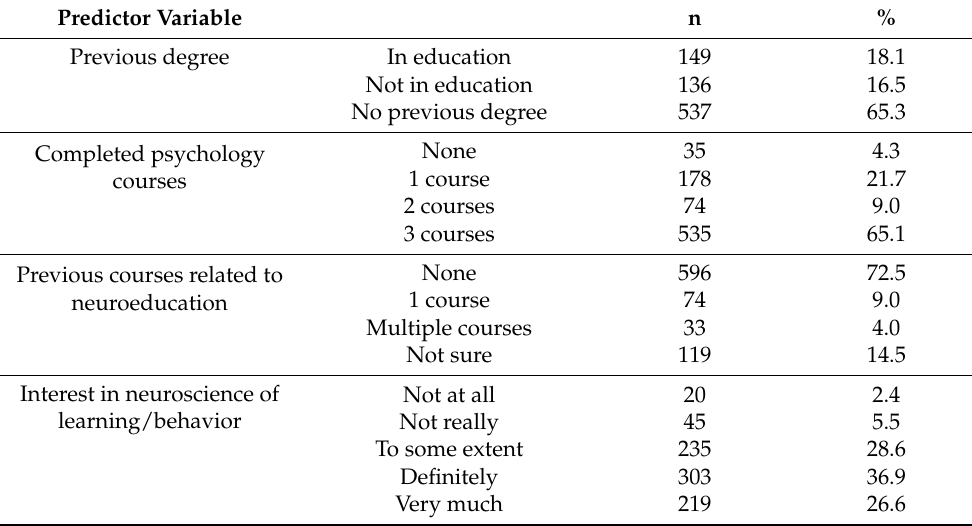
Table 3. Previous education and interest in